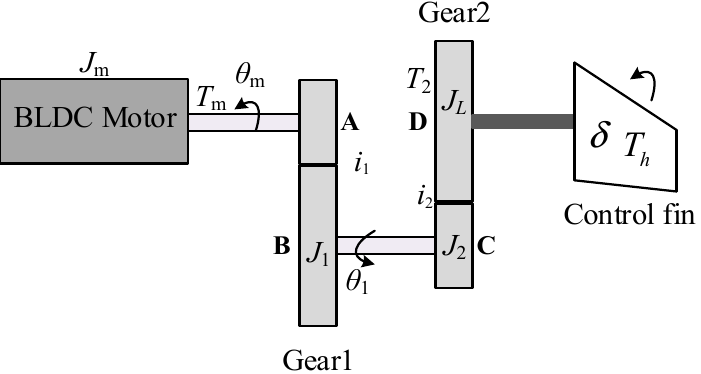
Figure 1. Schematic diagram of EMA system.